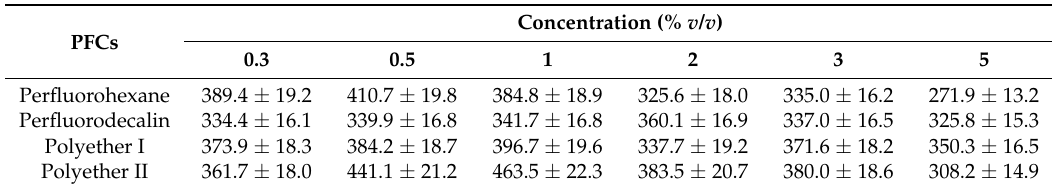
Table 3. Total His 6 -OPH activity (U/L), accumulated in the E. coli SG13009[pREP4] cells in the presence of various PFCs in the culture medium *.